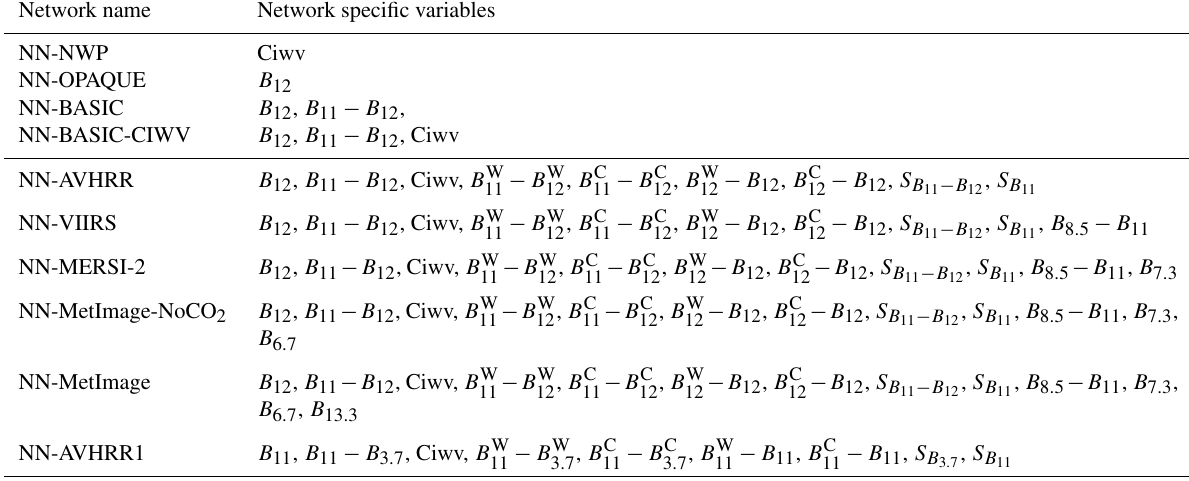
Table 3. Description of the different networks. See Table 2 for explanation of the variables. The NWP variables: P S , T S , T 950 , T 850 , T 700 , T 500 , T 250 are used in all